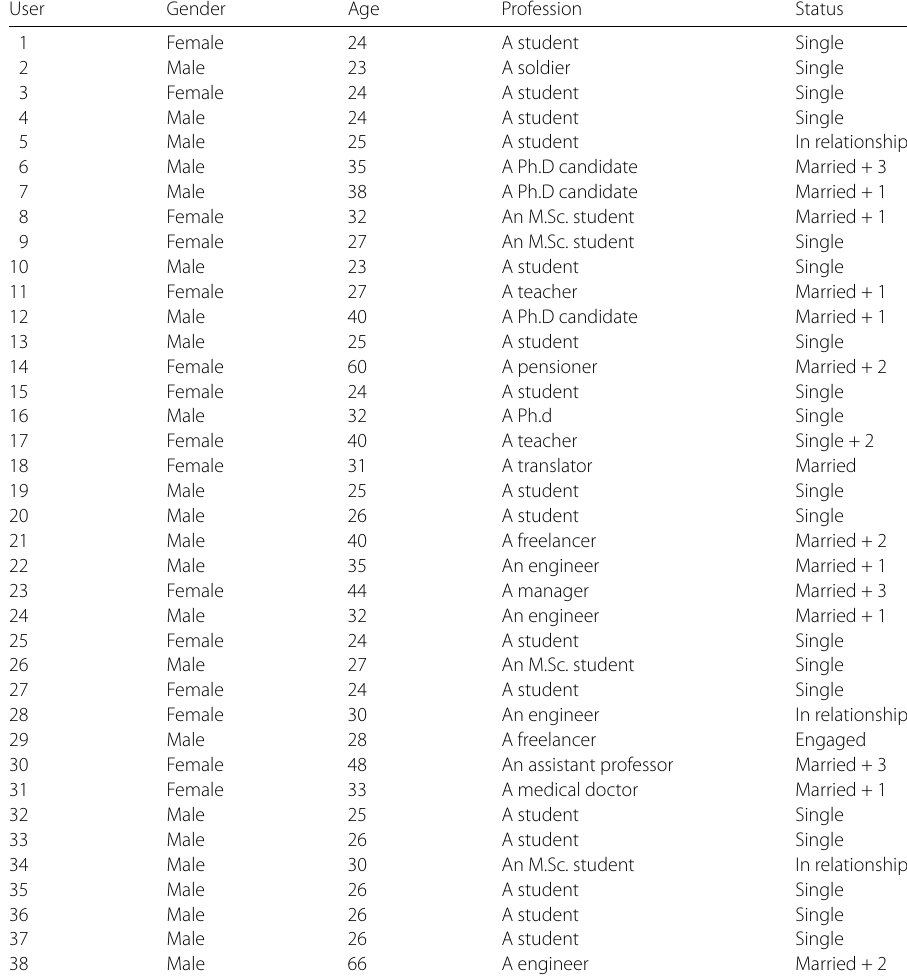
Table 2 Description of the 38 users User